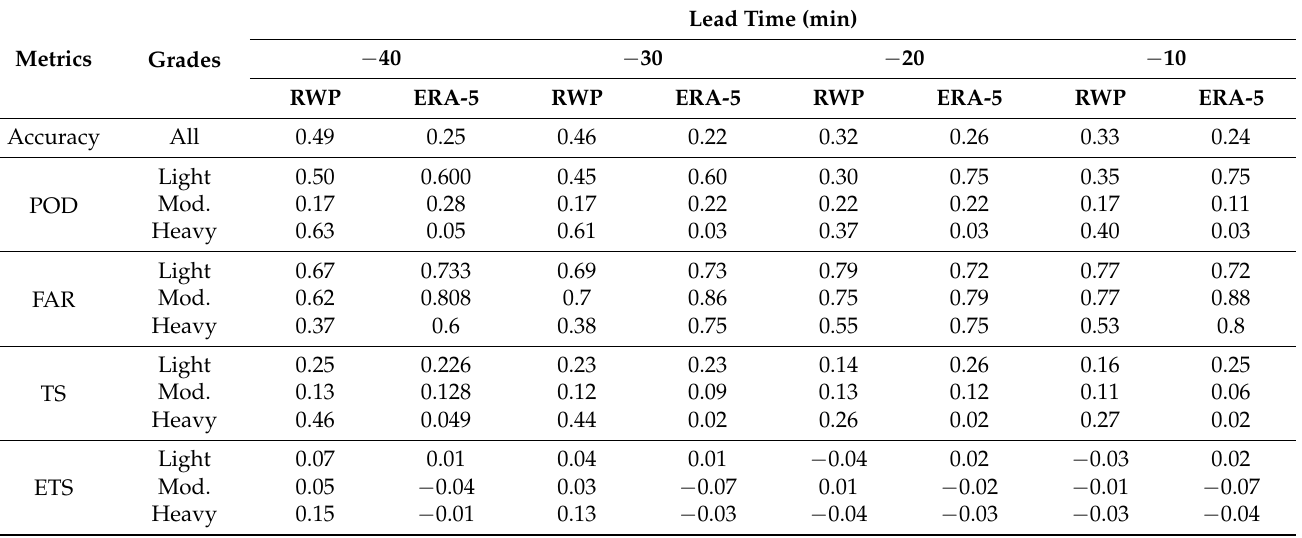
Table 5. The same as Table 4, but for the grade forecast of the rainfall case that occurred at 12:10 BJT on 12 August